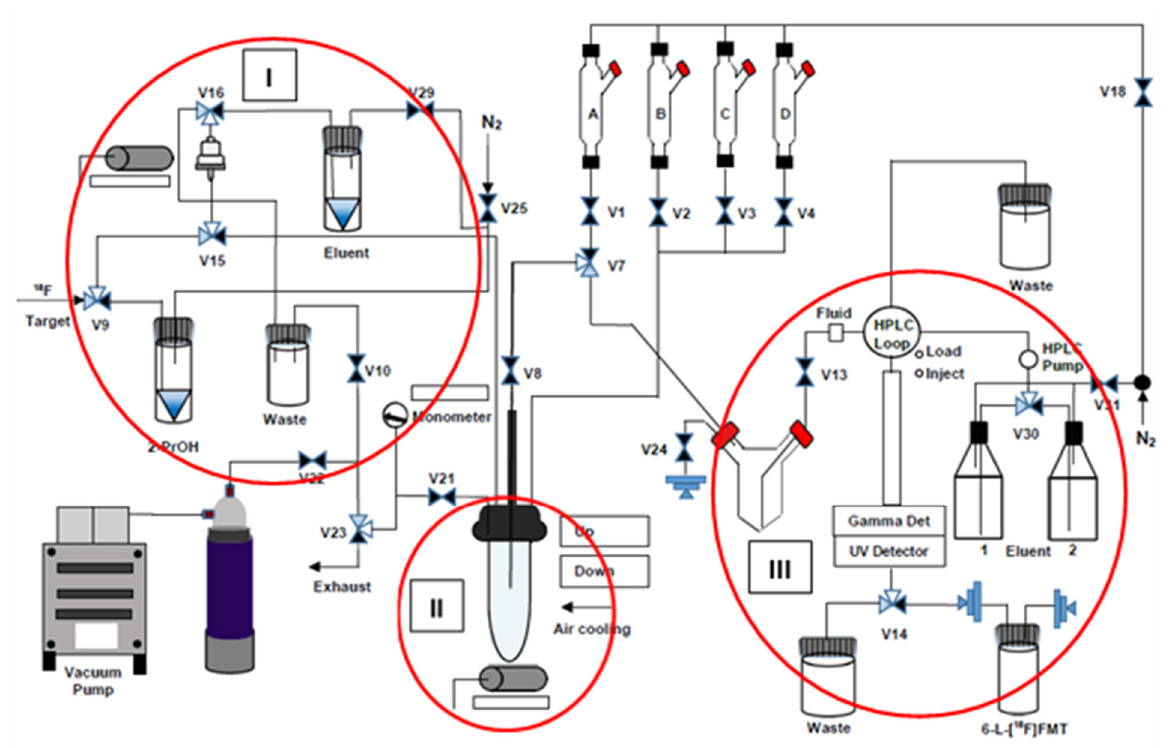
Figure 5. Schematic diagram of the GE TRACERlab FX-C Pro module modified for the preparation of 6- L -[ 18 F]FMT. A : empty vessel; B : 0.5 N HCl in 50% MeOH (1 mL); C : MeOH (0.5 mL); D : 0.1% AcOH (1.5 mL); RV : 4 (7.7 mg, 10 µ mol) and Cu(py) 4 (OTf) 2 (11 mg, 16 µ mol) in MeCN (0.3 mL); eluent vial: Bu 4 NOTf (5 mg, 12.5 µ mol) in i PrOH (0.8 mL). RV—reaction vessel (2 mL). Table 2. Process sequence for the automated synthesis of 6- L -[ 18 F]FMT using the modified GE Tracerlab FX C Pro module (Figure